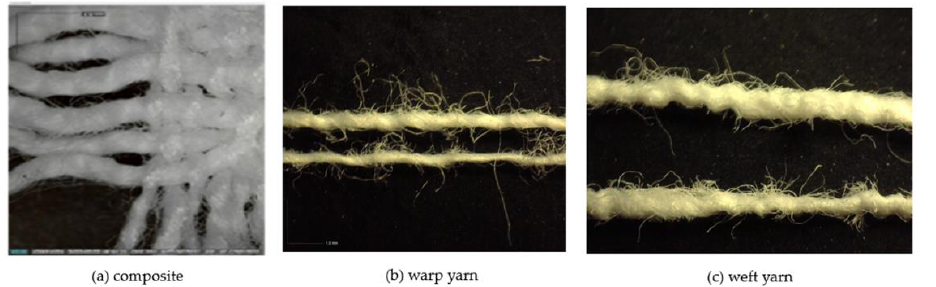
Figure 1. Digital micrographs of composite fabric with basic structural elements as pollution material magnification 55×.